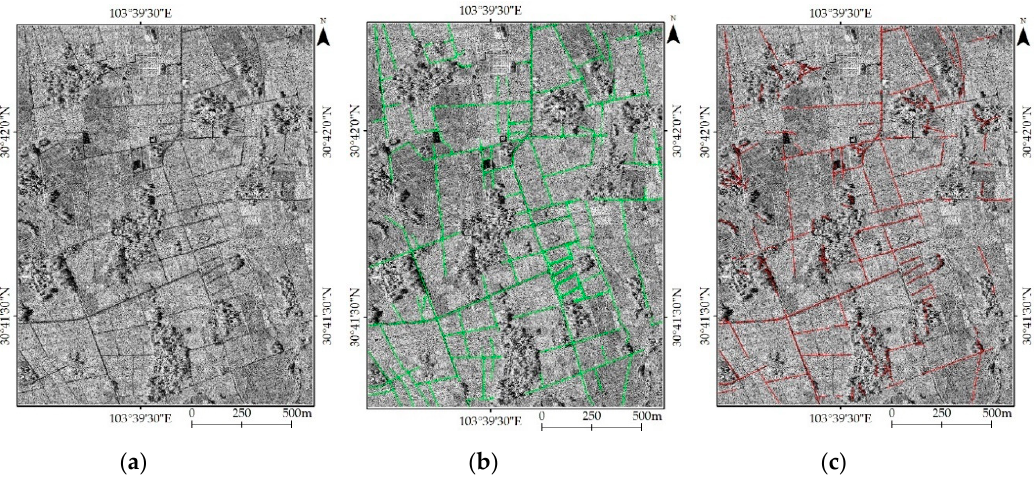
Figure 8. Road extraction results for study site 2. ( a ) Original SAR intensity image; ( b ) reference road network; ( c ) extracted road network with proposed method.